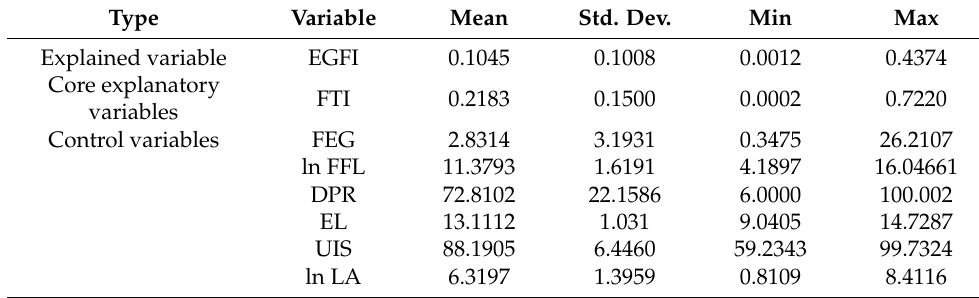
Table 2. Descriptive statistics of